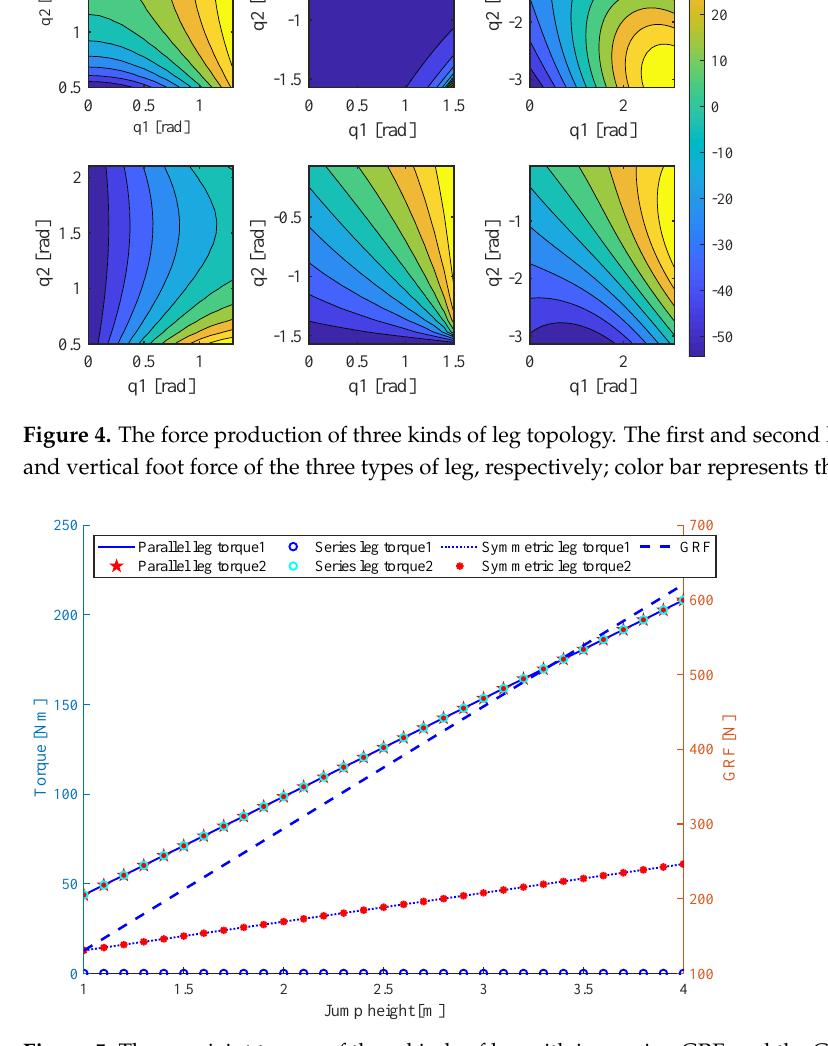
Figure 5. The max joint torque of three kinds of leg with increasing GRF, and the GRF corresponding to vertical jumping